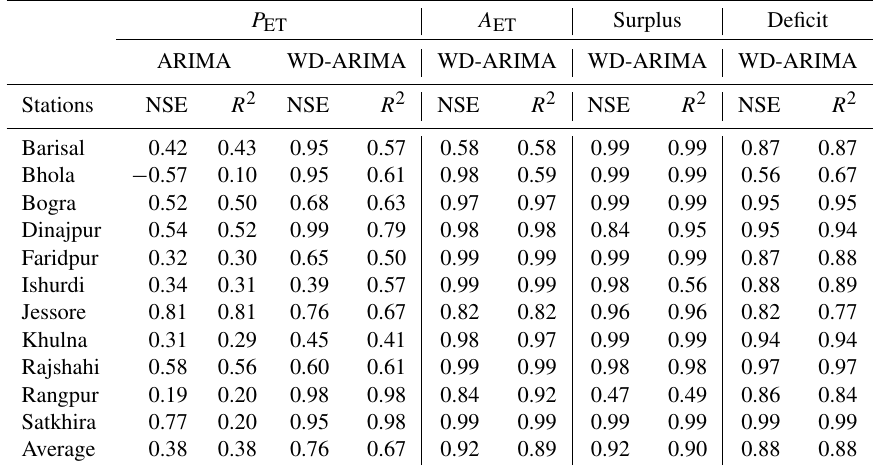
Table 3. Comparison of performance of ARIMA model and WD-ARIMA model.